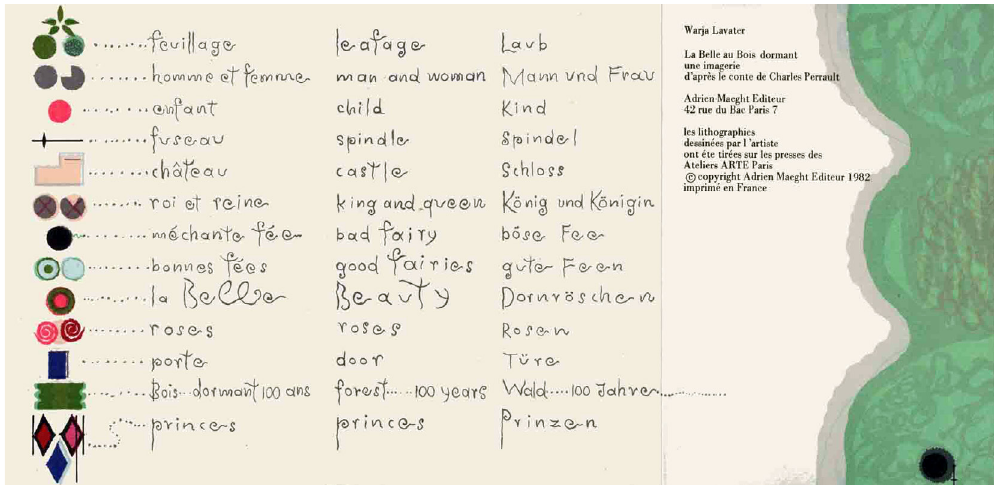
Fig. 14 Warja Lavater, Legend and colophone . Warja Lavater (1982). Maeght